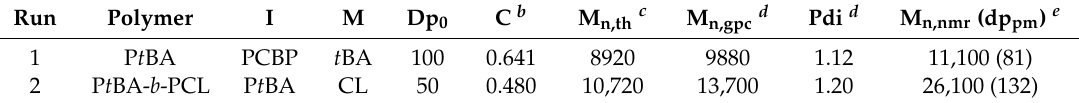
Figure 1. Synthetic Scheme of pH responsive diblock copolymer PAA- b -PCL. Table 1. Results for synthesis of P t BA and P t BA- b -PCL diblock copolymer a .